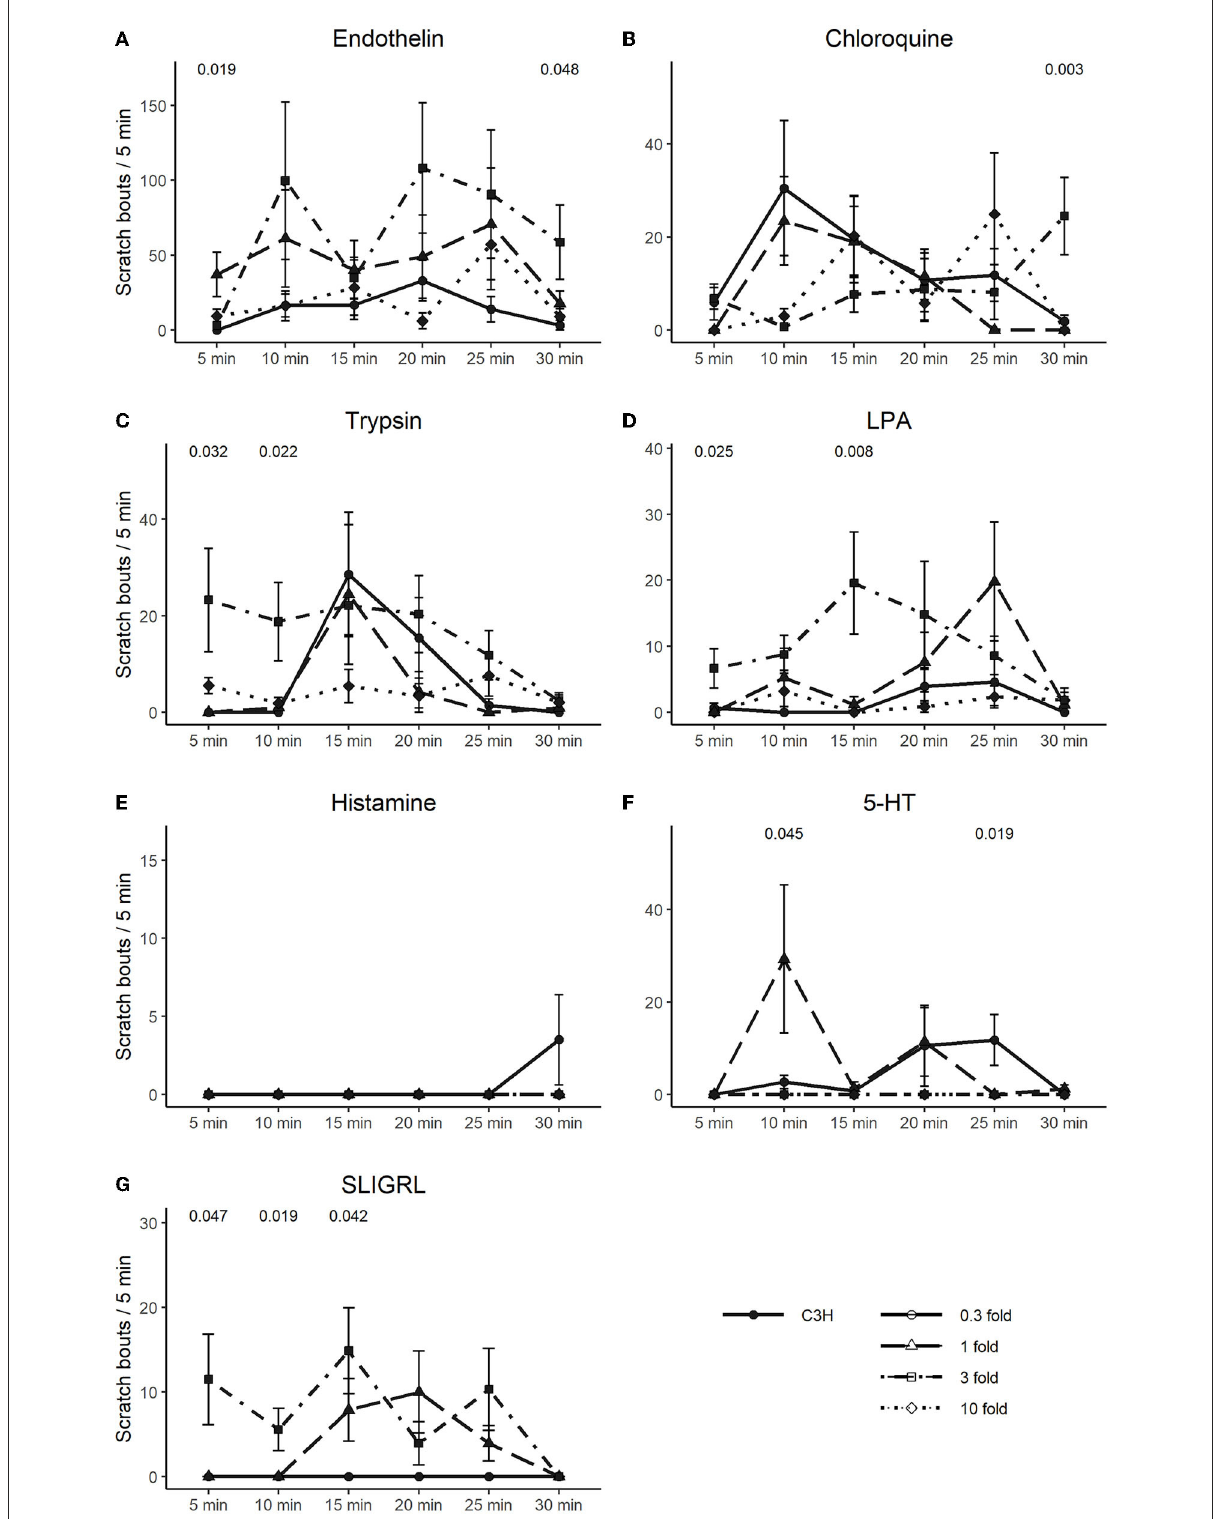
FIGURE5 Time-course of scratching bouts in C3H. Each data point represents the mean ± SEM of scratch bouts in bins of 5min in response to injection of, (A) endothelin, (B) chloroquine, (C) trypsin, (D) LPA, (E) histamine, (F) 5-HT, and (G) SLIGRL into the nape of the neck. Four different concentrations were tested. P -values are indicated at the top of each panel and result from a repeated measures ANOVA. The different concentrations are discerned by shape and line type (0.3-fold = circle, solid line; one-fold = triangle, long dashed line; three-fold = square, dot dashed line; 10-fold = diamond, dotted